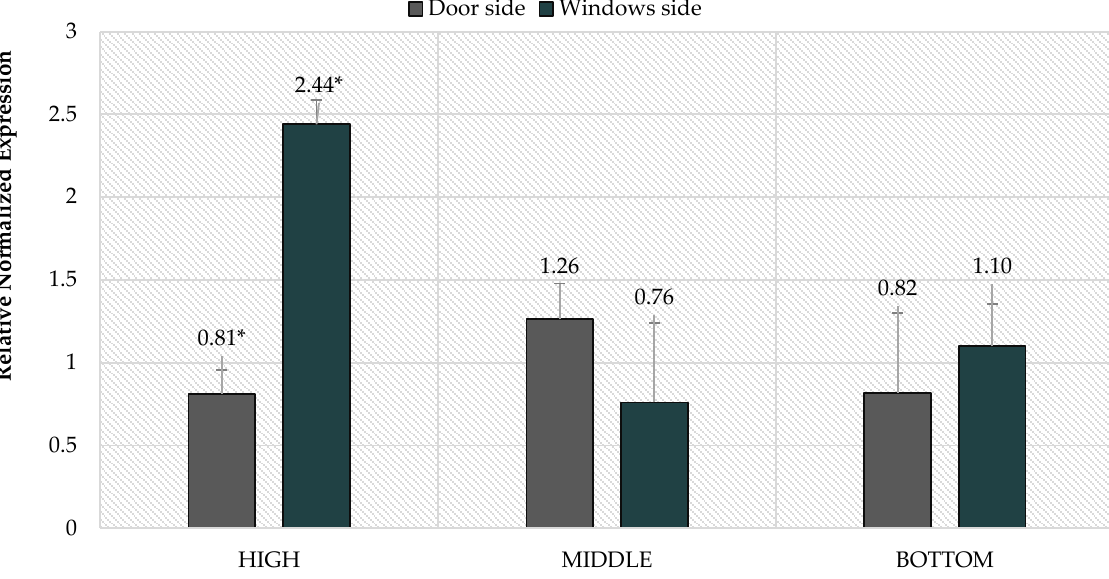
Figure 4. Level of relative normalized expression (RNE) of Lactobacillaceae family depending on the cage setting. * p = 0.0428.